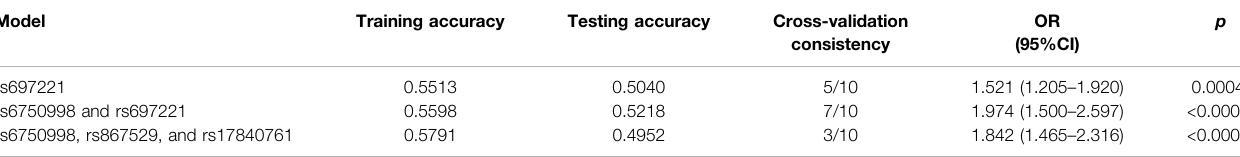
TABLE 8 | Summary of SNP-SNP interactions on the risk of lung cancer analyzed by MDR method.